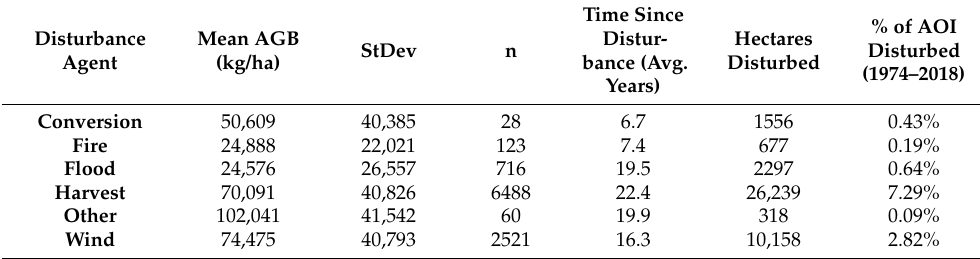
Table 4. Mean above ground biomass present on sites experiencing different agents of disturbance